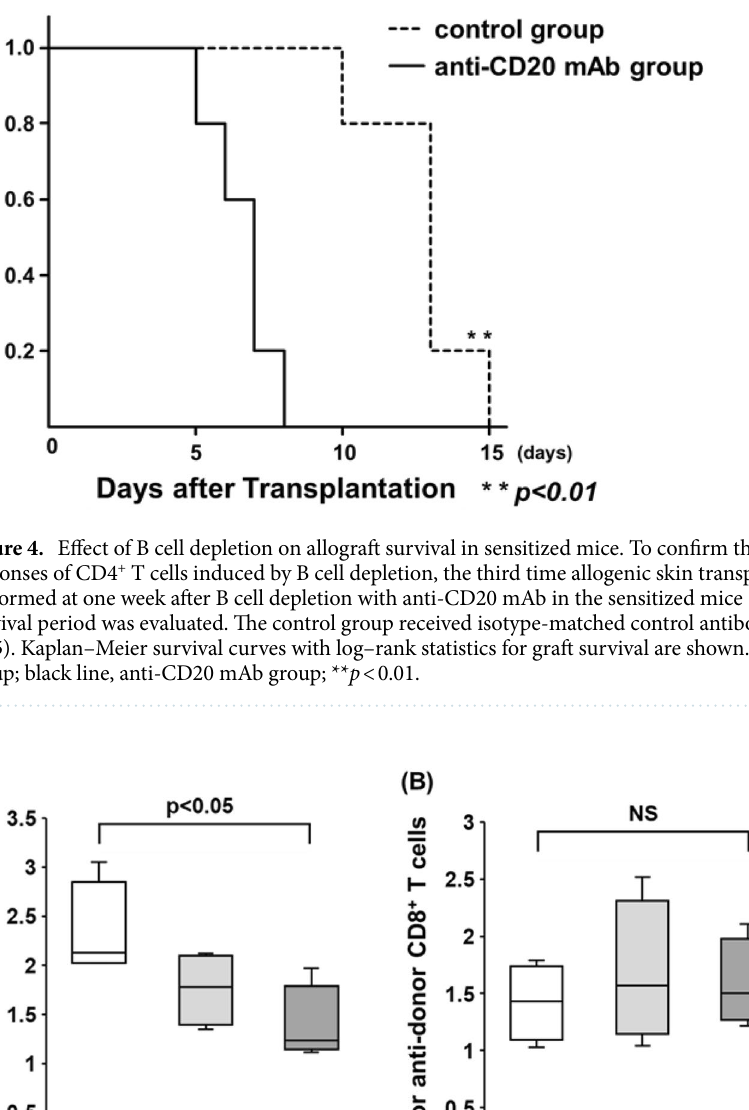
donor CD4 + T cell responses compared to those without B cell transfer ( p < 0.05, Fig. 5A). Similar results were observed with B cells from naïve mice (Figure S3). There were no significant differences in SI values for the CD8 + T cell responses to donor stimulation regardless of sensitization (Figs. 5B and S3). We have previously demonstrated that CD5 + B-1 cells contain a distinguished subset, which potentially sup- presses T cells responding to allostimulation 21 . Regardless of sensitization, CD5 + B cells were a small subpopula- tion of splenic B cells (Fig. 6A).